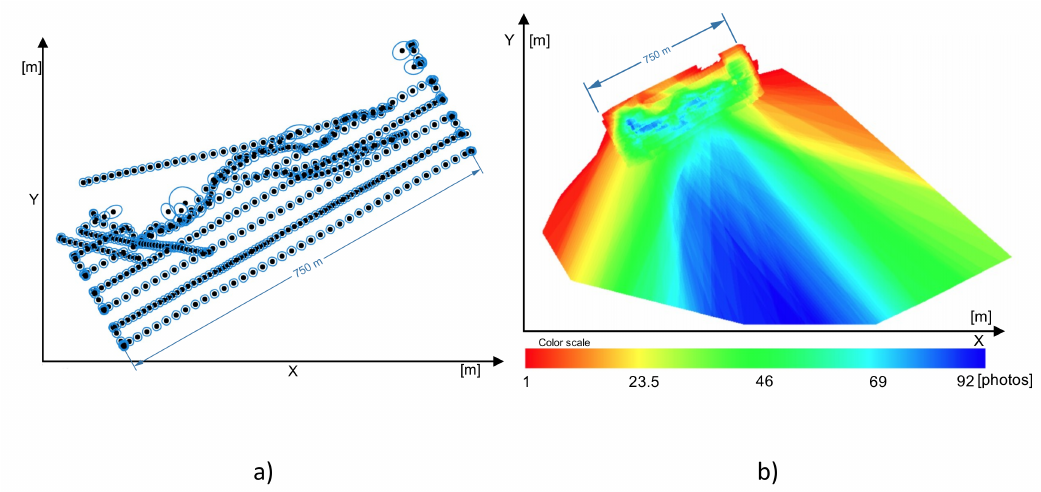
Figure 5. ( a ) Camera position uncertainties (XY plane), where blue ellipses indicate the position uncertainty, scaled for readability; (b) Number of photographs that potentially see the scene.